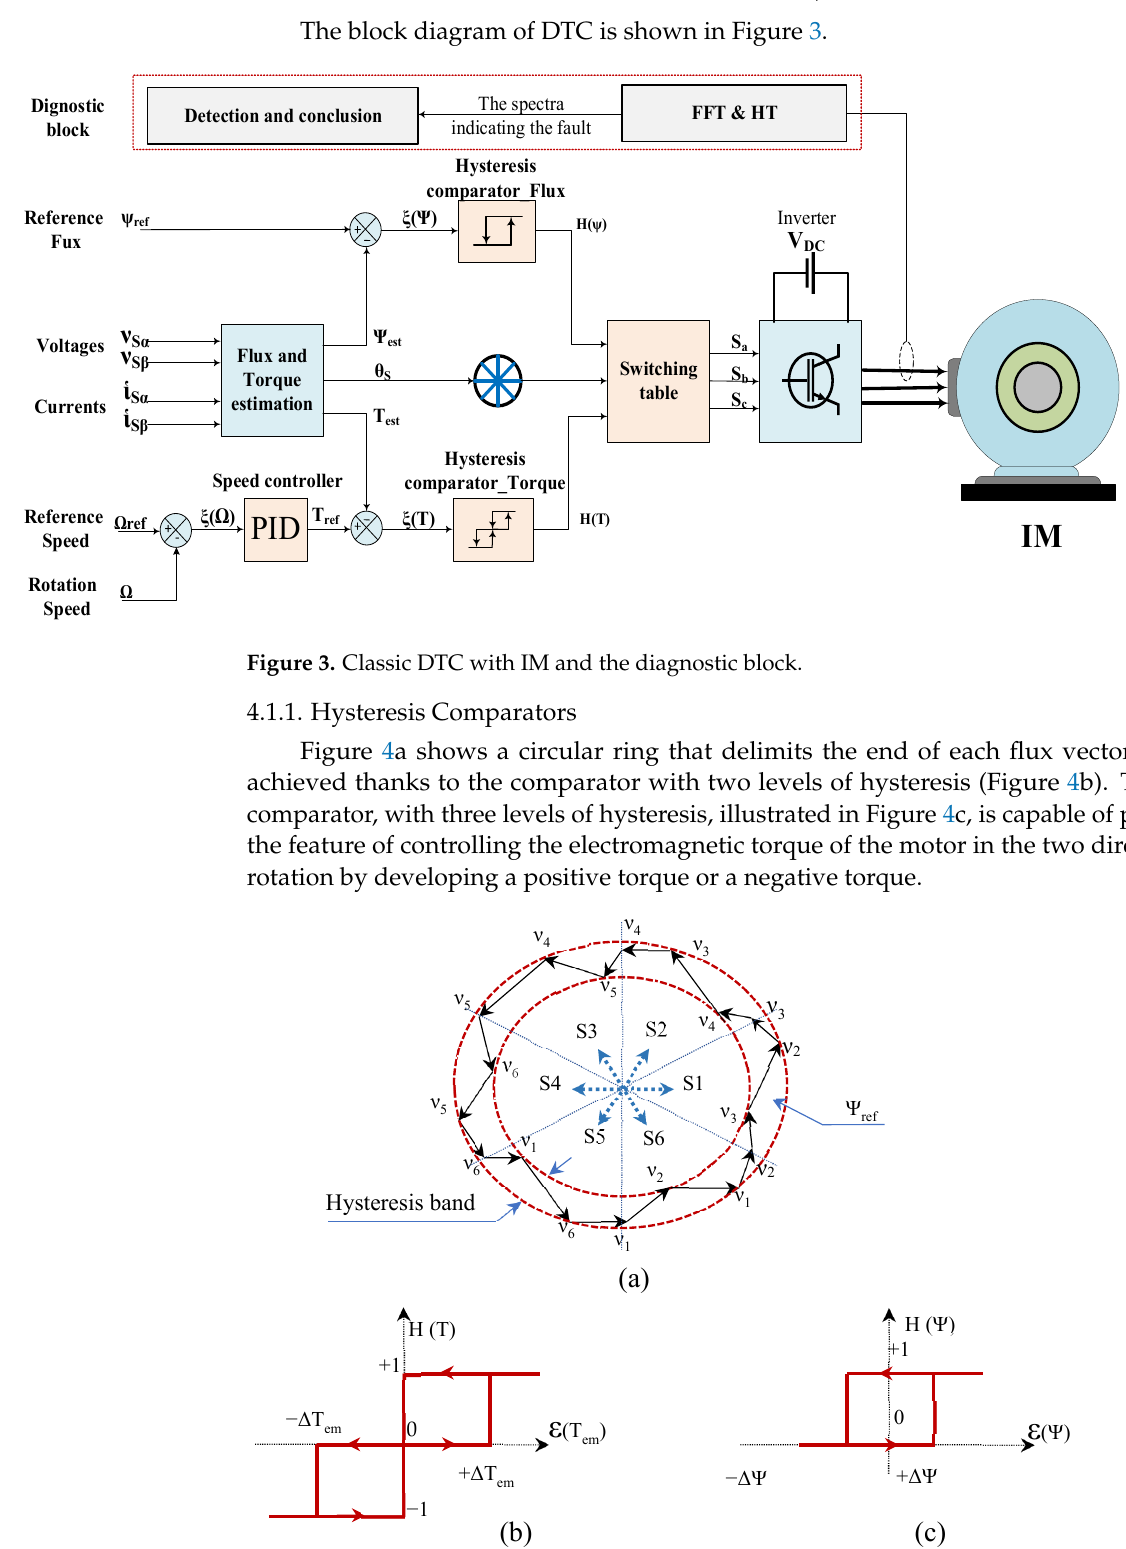
Figure 4. ( a ) Flux trajectory. Hysteresis comparators: ( b ) three − level torque, ( c ) two − level flux.